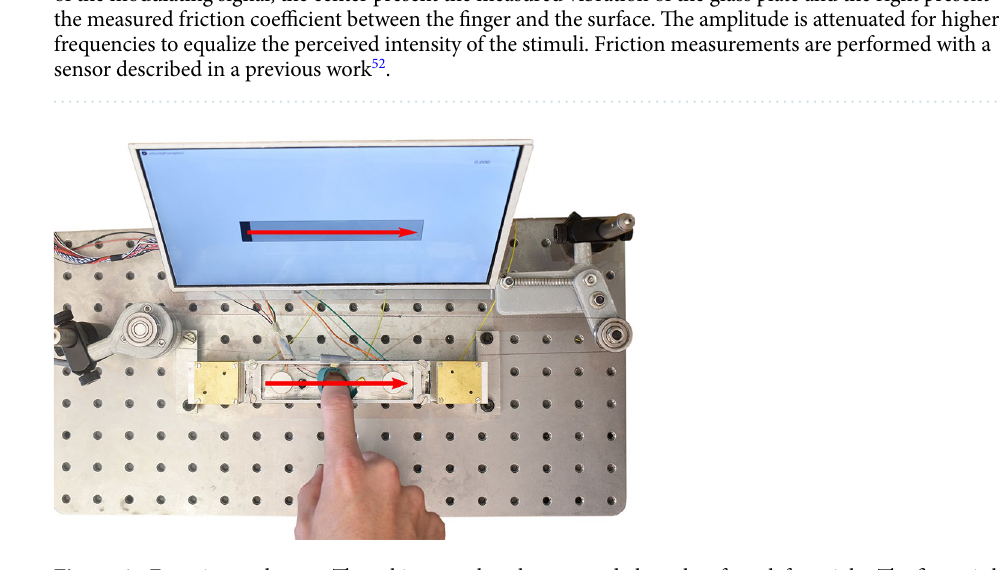
Figure 6. Experimental setup. The subject touches the actuated glass plate from left to right. The finger is linked to a pulley-encoder system for position measurement. The screen shows a cursor imposing the finger